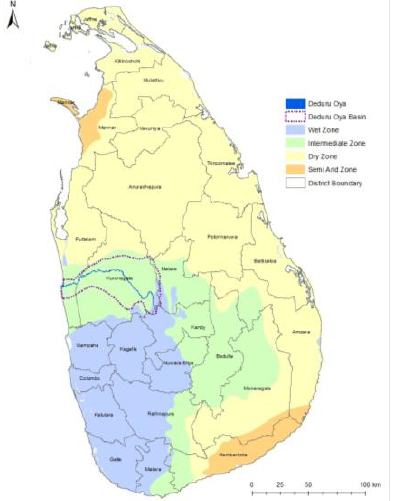
Figure 2. Climatic zones of Sri Lanka and the location of